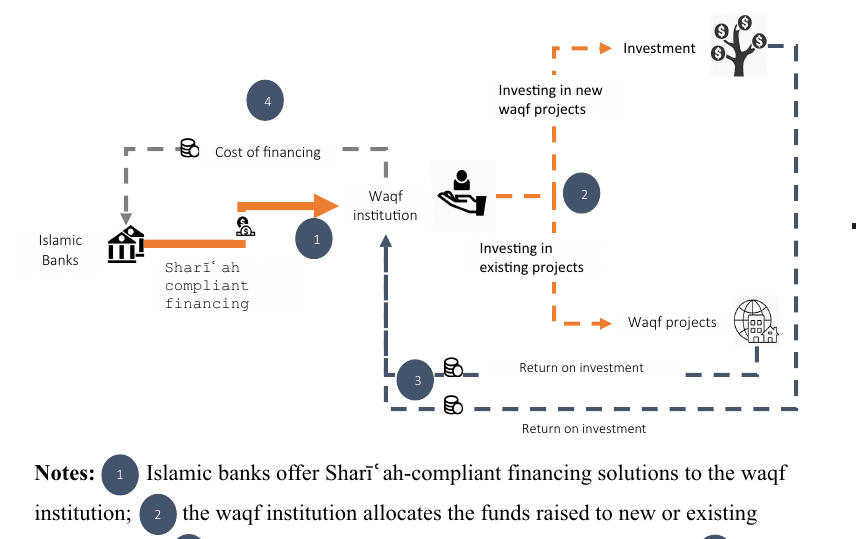
Figure 6. Islamic banks fi nancing waqf